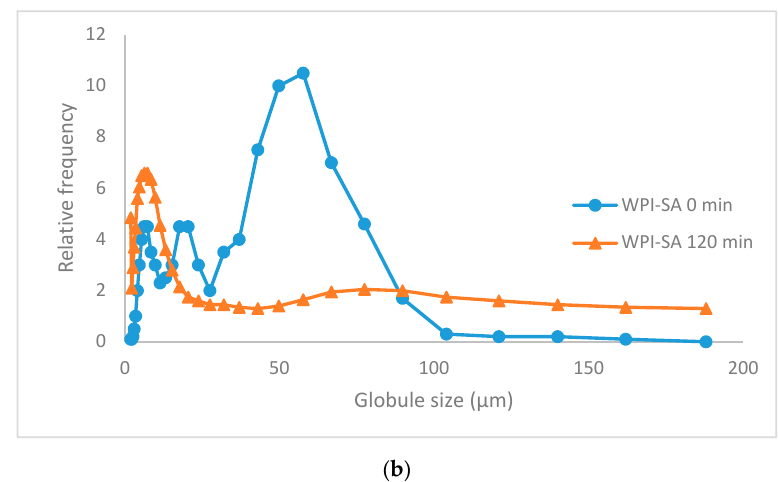
Figure 5. Particle size distribution of coacervated microcapsules with ( a ) WPI–CMC and ( b ) WPI–SA systems at the beginning (0 min) and end (120 min) of intestinal digestion.